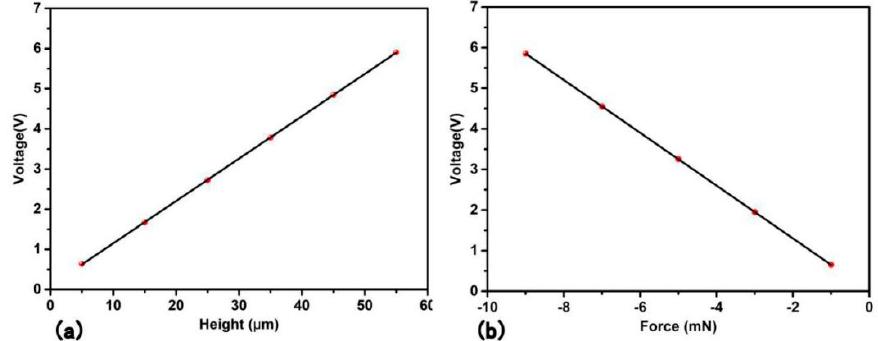
Figure 8. ( a )The relationship between height and voltage. ( b ) The relationship between force and voltage. The minus force denotes the direction of the force goes in the normal direction to the inner part of the structure.